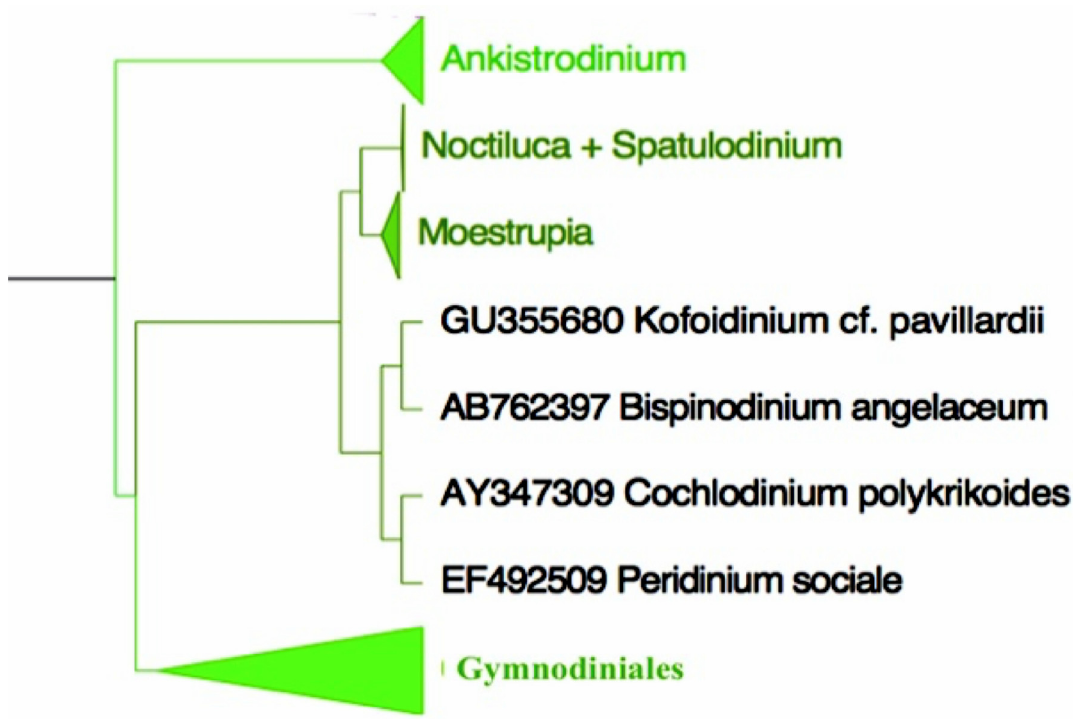
Figure 10. Enlarged view of Clade 3A i.